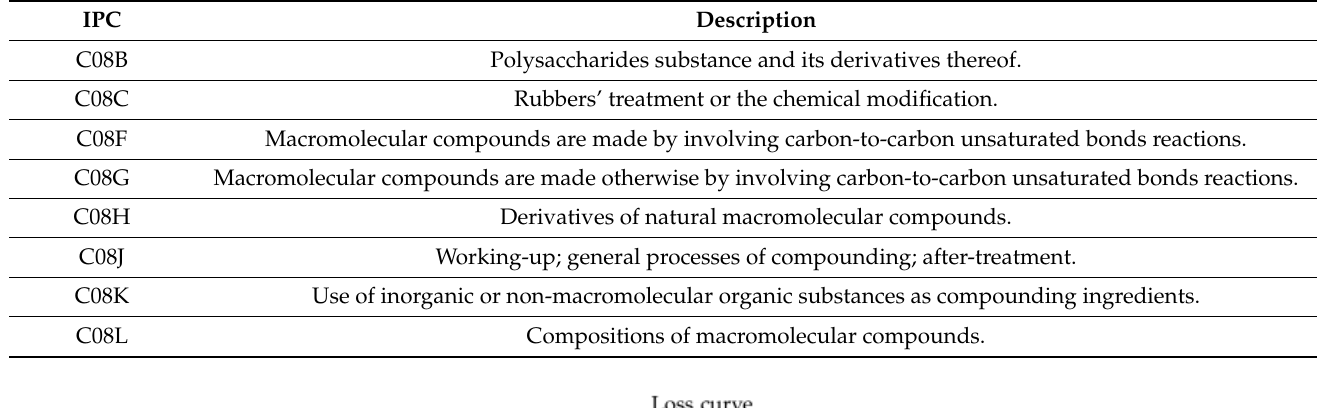
Table 2. List of International Patent Classifications (IPCs).